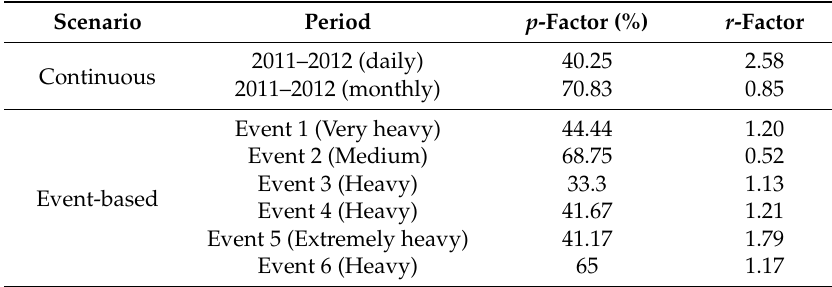
Figure 11. Hyetograph, observations, and 95 PPU bounds of streamflow in the representative rainfall–runoff events. Table 7. Measures for uncertainty analysis in the continuous and event-based